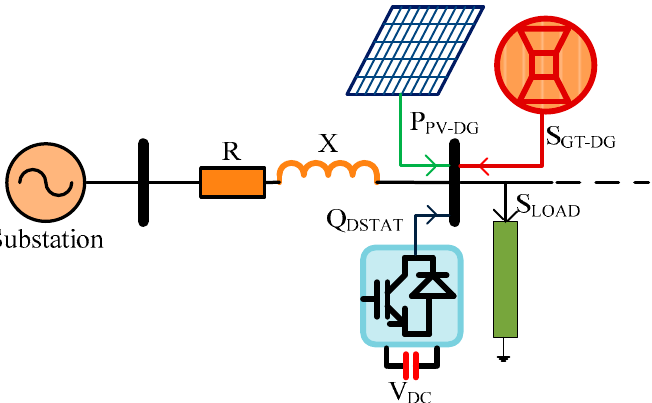
Figure 1. A simplified two-node equivalent of a DN connected to DGs and DSTATCOM.